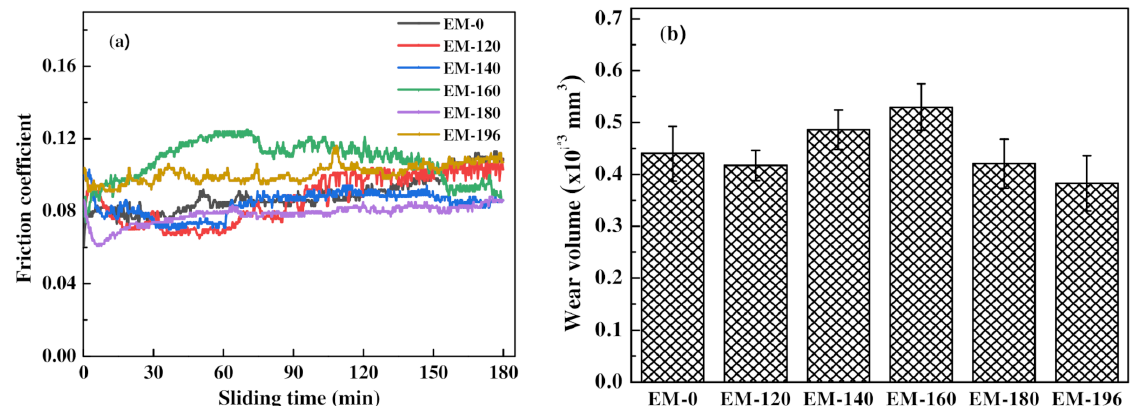
Figure 5. Residual stress ( a ), adhesion strength ( b ), and hardness ( c ) of specimens subjected to different treatments.